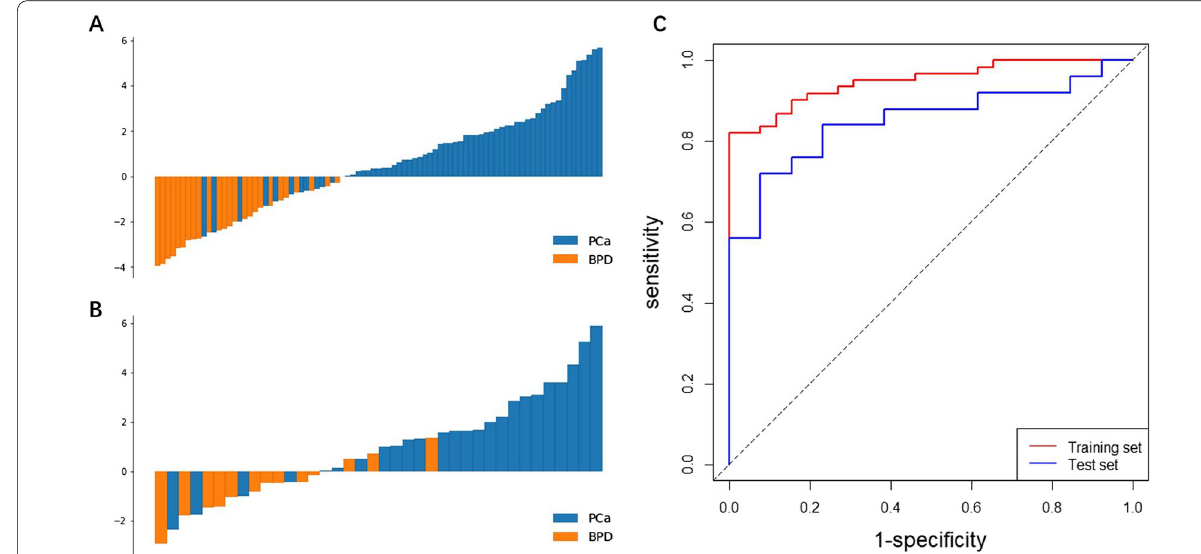
Fig. 3 Diagnostic performance of the radiomics model. Model scores for patients in the a training and b test sets. c Receiver operating characteristic (ROC) curves of radiomics model in the training and test sets. PCa, prostate cancer; BPD, benign prostate disease